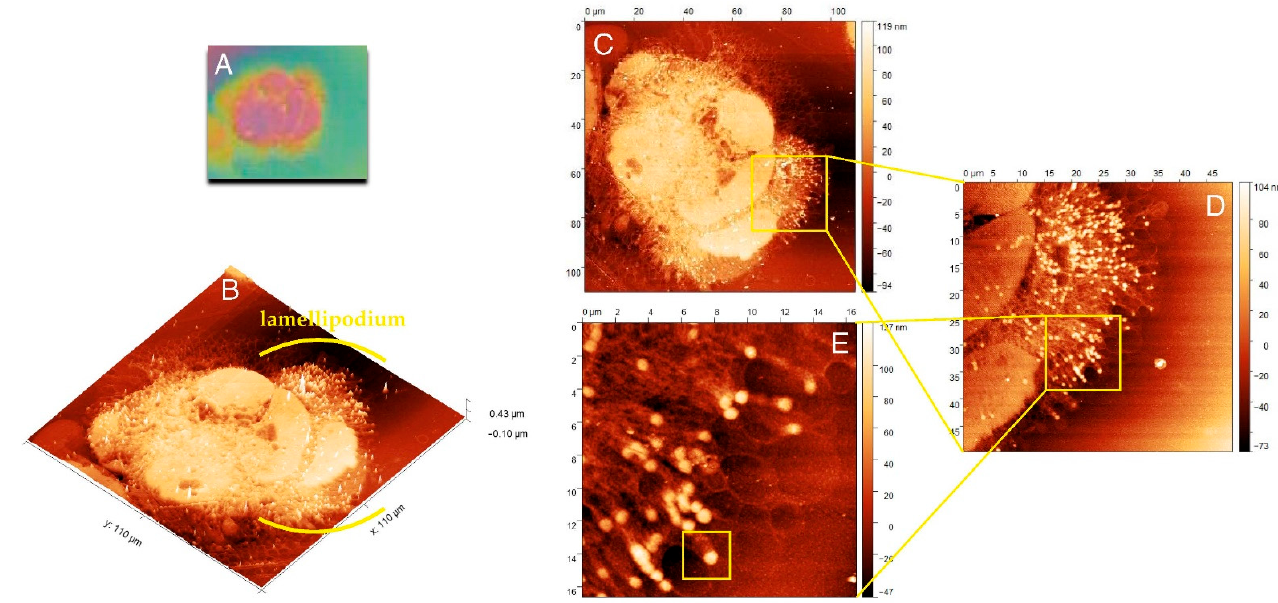
Figure 2. Morphology and internal structure of lamellipodium of HCC38 human breast cancer cells. ( A ) The preview image of HCC38 cells imprints obtained using AFM with the built-in 10× light-lens. AFM images of unfixed ( B – E ) HCC38 human breast cancer cells imprint after the exposure to X-rays in laser plasma-based SXCM. Topographies of the cell imprints performed in different scan size: ( B , C ) 110 µ m × 110 µ m; ( D ) 50 µ m × 50 µ m; ( E ) 16.5 µ m × 16.5 µ m. In the image ( E ) are marked single FA substructure. AFM images were processed using the Gwyddion 2.53 software.